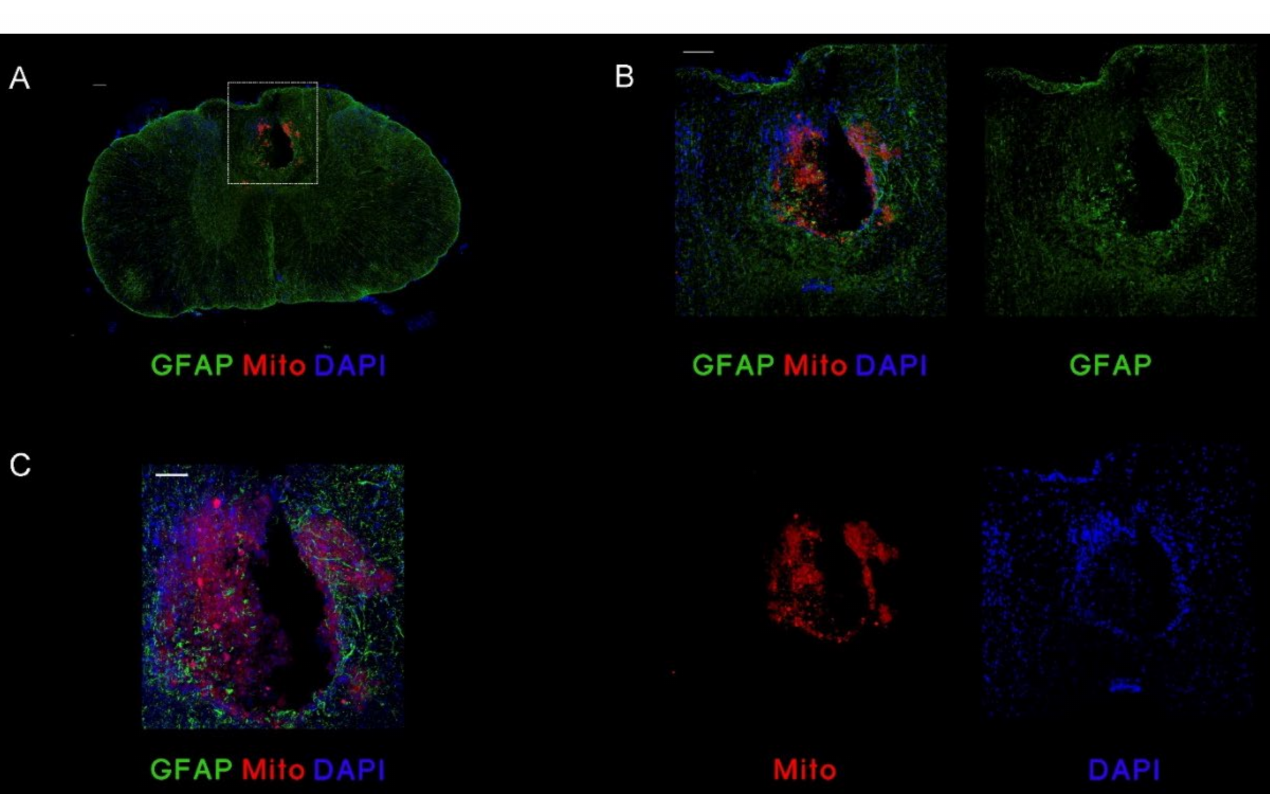
Figure 5. MSC,WJ localization after intrathecal administration at 9 days post-lesion (dpl) and 2 days post-injection (dpi). Representative images of rats with transplanted MSC,WJ. Cells were injected intrathecally (L3–L4). After 2 days, staining for Mito was observed inside the lesion site. ( A ) Representative microphotography of transversal section showing injured spinal cord at 9 dpl after 2 dpi intrathecal injection of MSC,WJ. ( B ) Magnification of injured spinal cord (from white box on A) showing GFAP staining in green, Mito staining in red and 4 (cid:48) ,6-diamidino-2-phenylindole (DAPI) staining in blue. MSC,WJ can be identified into the lesion site. ( C ) Confocal microphotography shows localization of engrafted cells at lesion site. Bar scale: 100 µ m. n =